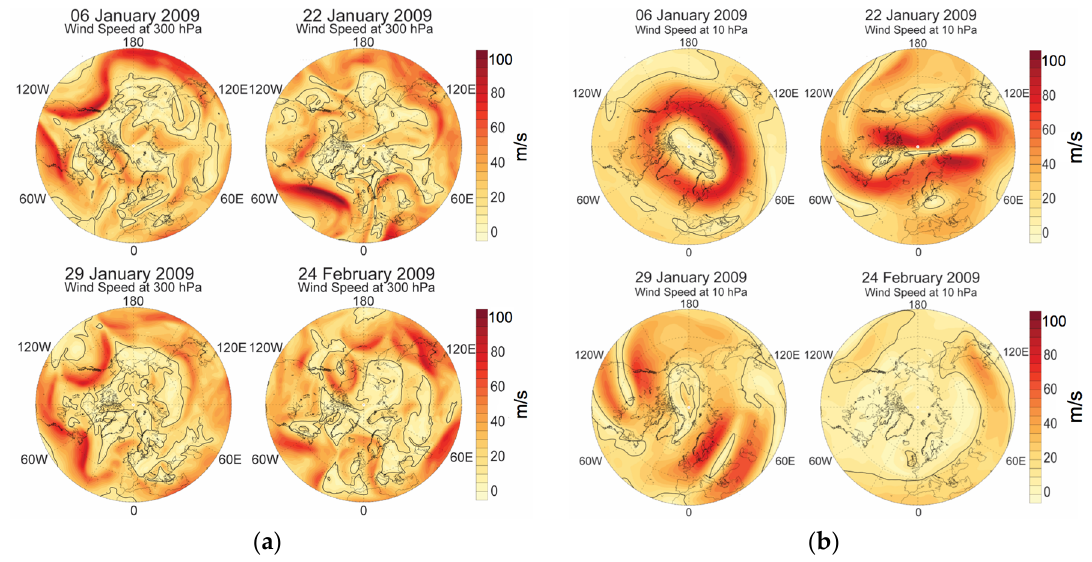
Figure 7. MERRA horizontal wind speed plotted in false color for four days in January and February 2009 at ( a ) 300 hPa (~9 km) and ( b ) 10 hPa (~31 km). The solid line is the 15 m/s contour.